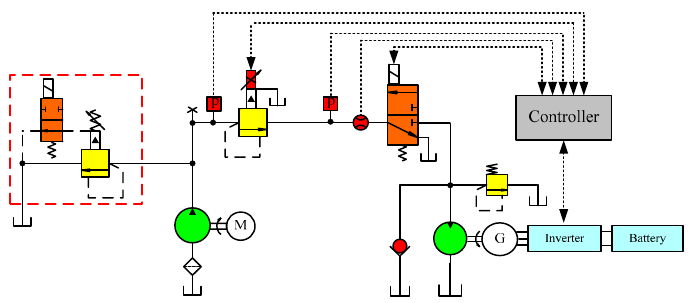
Figure 13. The system schematic diagram.